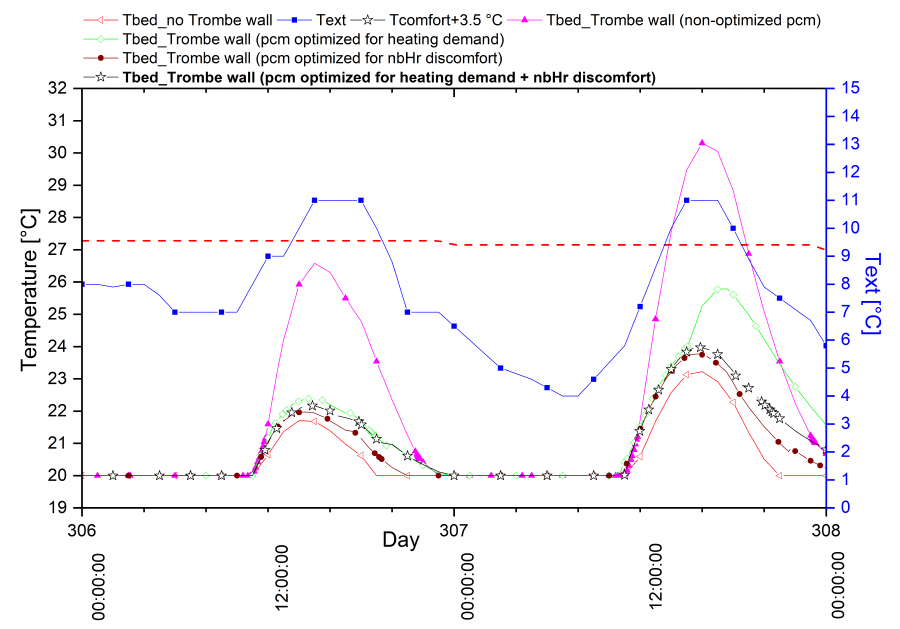
Figure 23. Temperature variations inside the bedroom set up with four different PCM storage